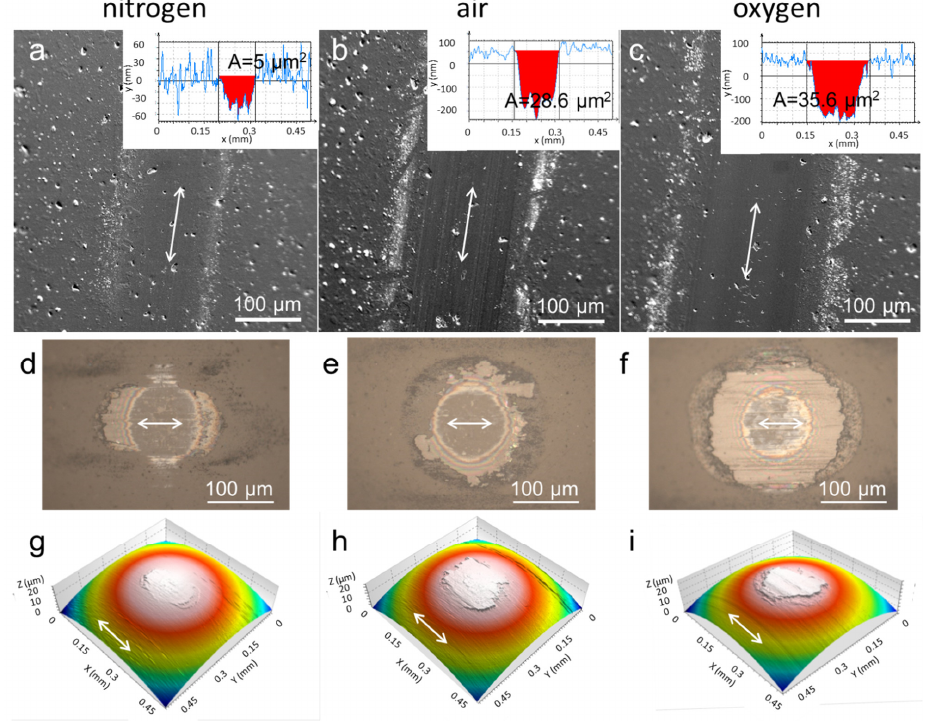
Figure 16. ( a – c ) SEM images of wear tracks formed in CC7 TiN coating during a reciprocating sliding test performed in nitrogen ( a ), ambient air ( b ), and oxygen ( c ) atmospheres. The cross-section areas (A) of corresponding wear tracks after 1000 cycles are shown in the insets. The areas of alumina ball wear scar are shown in the optical microscopy images ( d – f ) and 3D profilometer images ( g – i ). The images reveal the existence of transfer layers on the alumina ball for all testing atmospheres. Arrows indicate the sliding direction.